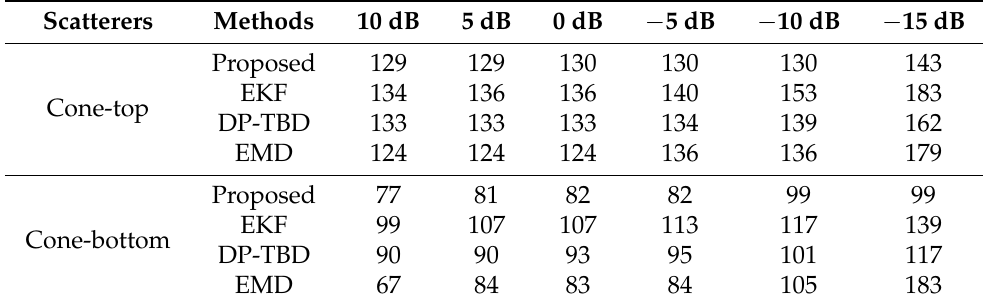
Table 3. Comparison of the RMSEs ( × 10 − 4 ) (m) among the proposed method, the EKF method, the traditional DP-TBD method, and the EMD method with different SNR conditions.